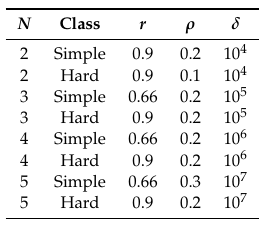
Table 3. Control parameter of the GKLS